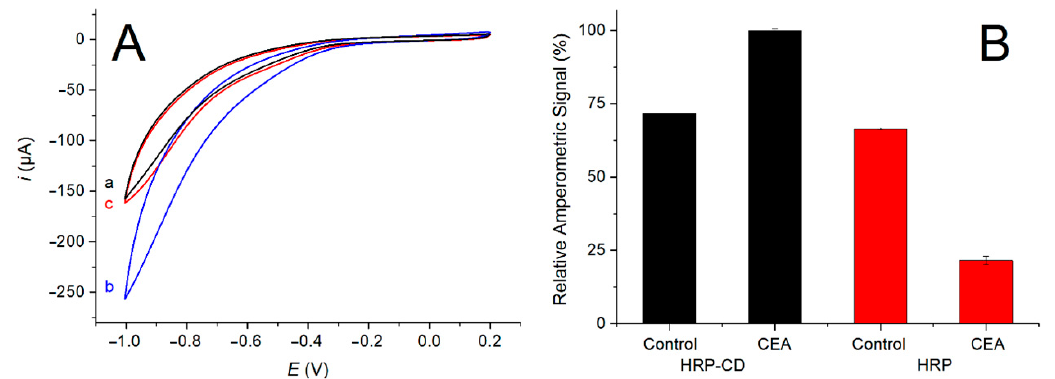
Figure 4. ( A ) Cyclic voltammograms for CEA/Apt-ADA/AuNF/GO/SPE at 50 mV/s in 50 mM H 2 O 2 , 0.1 M sodium phosphate buffer, pH 7.4 before ( a ) and after sequential incubation with HRP-CD in the absence ( b ) and the presence of 2-adamantanoic acid sodium salt ( c ). ( B ) Relative amperometric response for the aptasensor after sequential incubation with 20 pg/mL CEA or buffer (control), and HRP-CD or